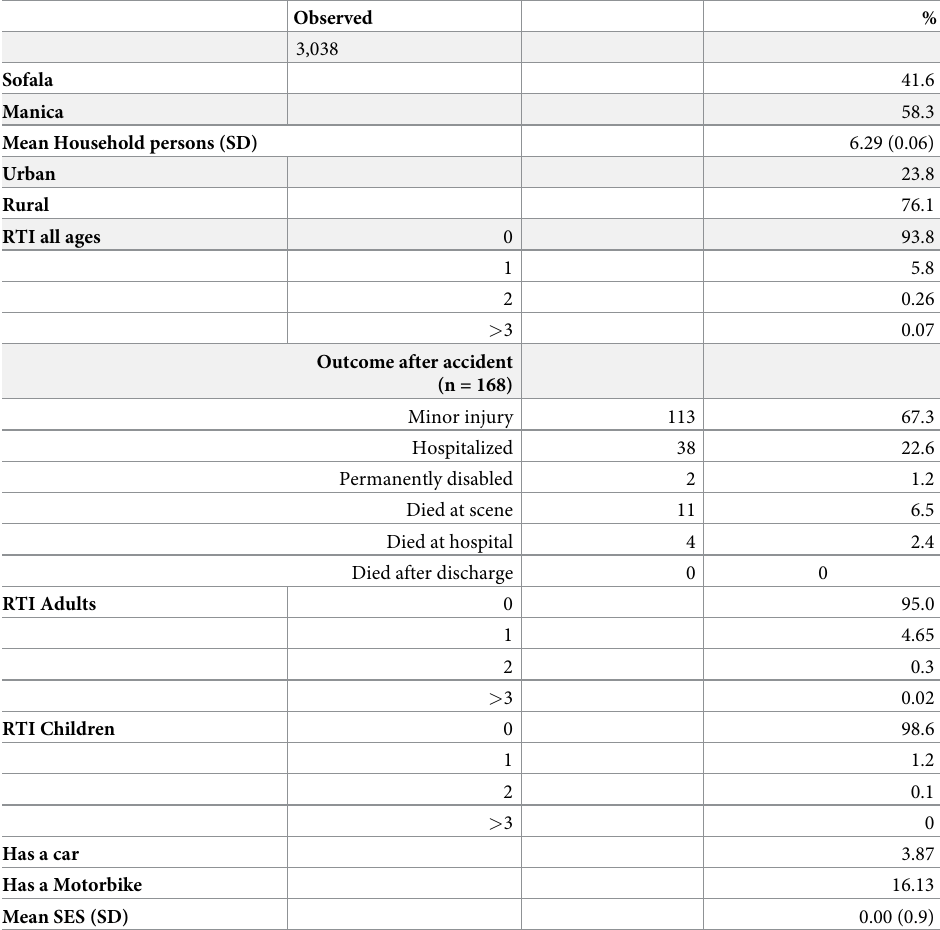
Table 1. Descriptive statistics of the Sofala and Manica